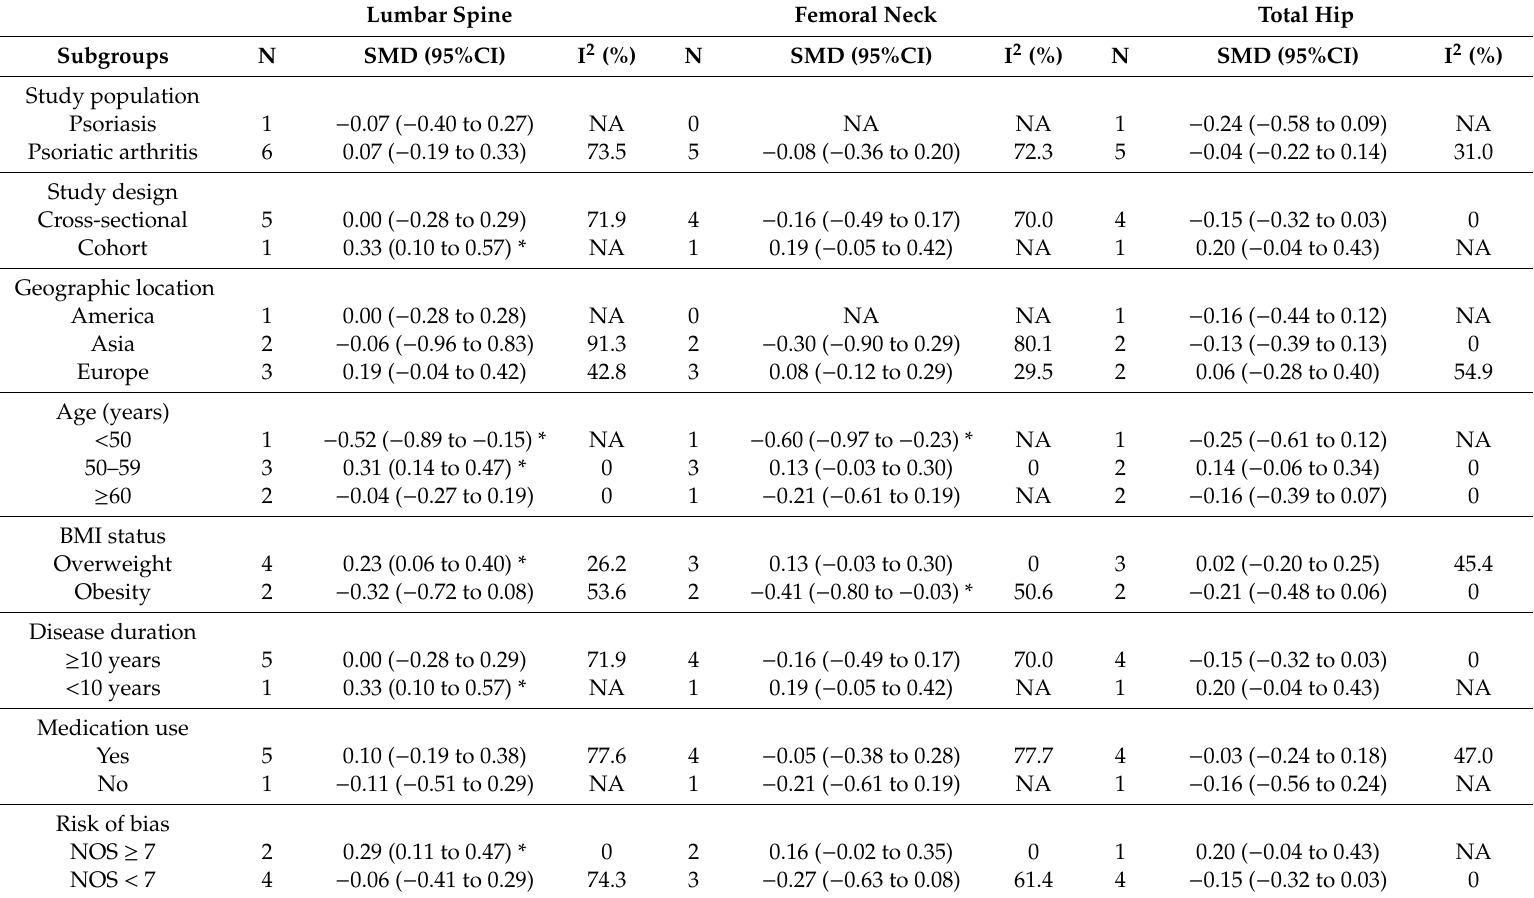
Table 1. Subgroup analysis of primary